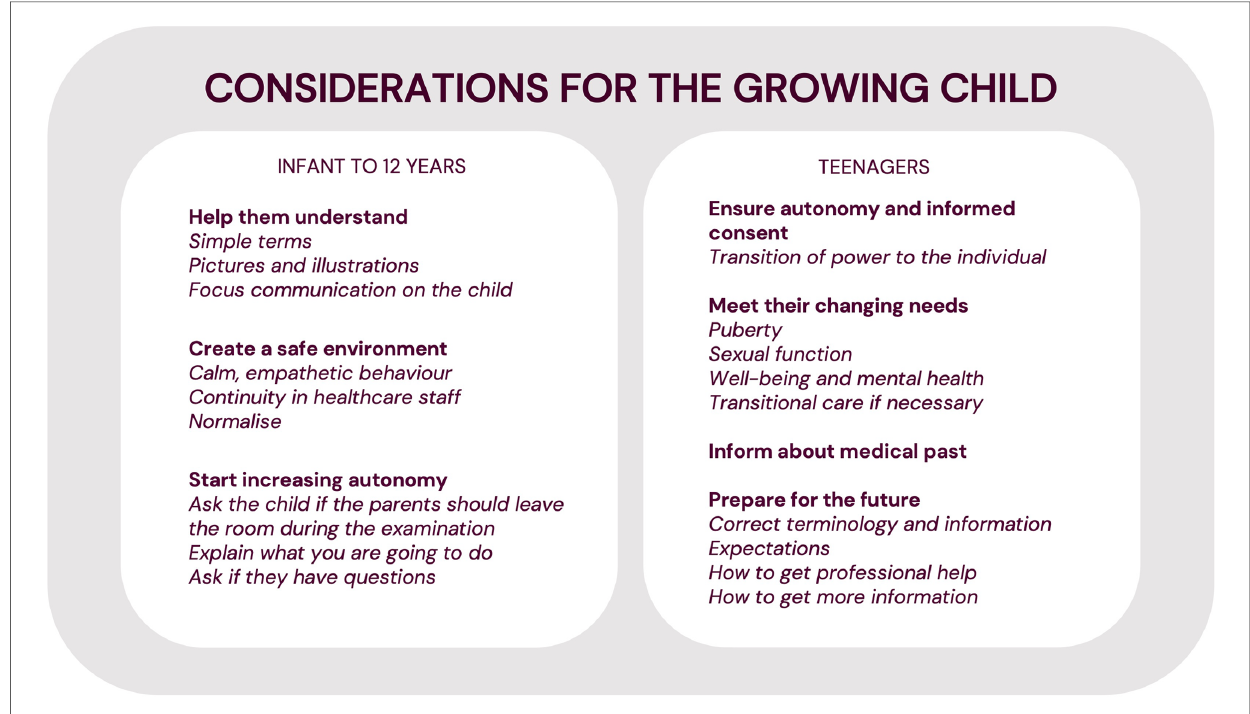
FIGURE 4 Summary of recommended considerations for the growing child in hypospadias